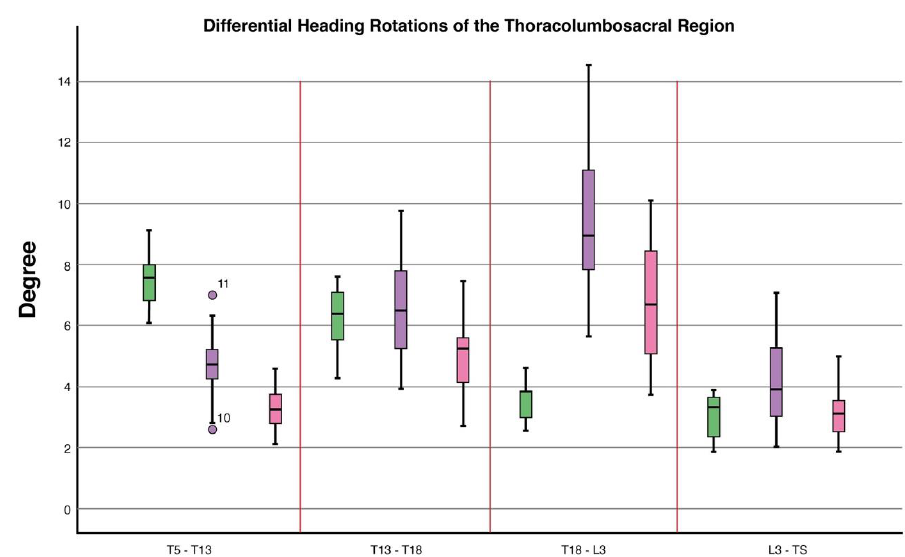
Figure 5. Boxplots displaying differential roll rotations of the thoracolumbosacral spine in 10 dressage horses whilst trot- ting in-hand and when being ridden in sitting trot and canter. At T5-T13, differential roll rotations differed between con- ditions ( p = 0.04) where a decrease in differential roll rotations when in canter compared to trotting in-hand ( p = 0.005) was found. At L3-TS, differential roll rotations differed between conditions ( p = 0.05); however, no differences were found between conditions in post hoc analysis. Explanation of symbols: the central line represents the median; the box represents the 25th and 75th percentiles; the whiskers represent the maxima and minima not considered to be outliers; ° represents outliers. Boxplot ID: green = in-hand trot, purple = sitting trot and pink = canter.